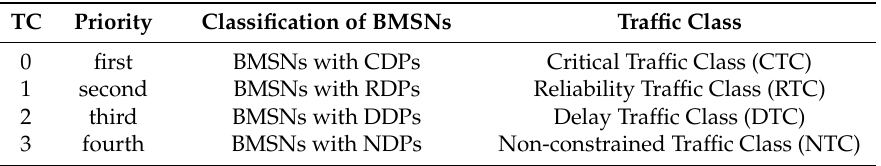
Table 1. Traffic Class